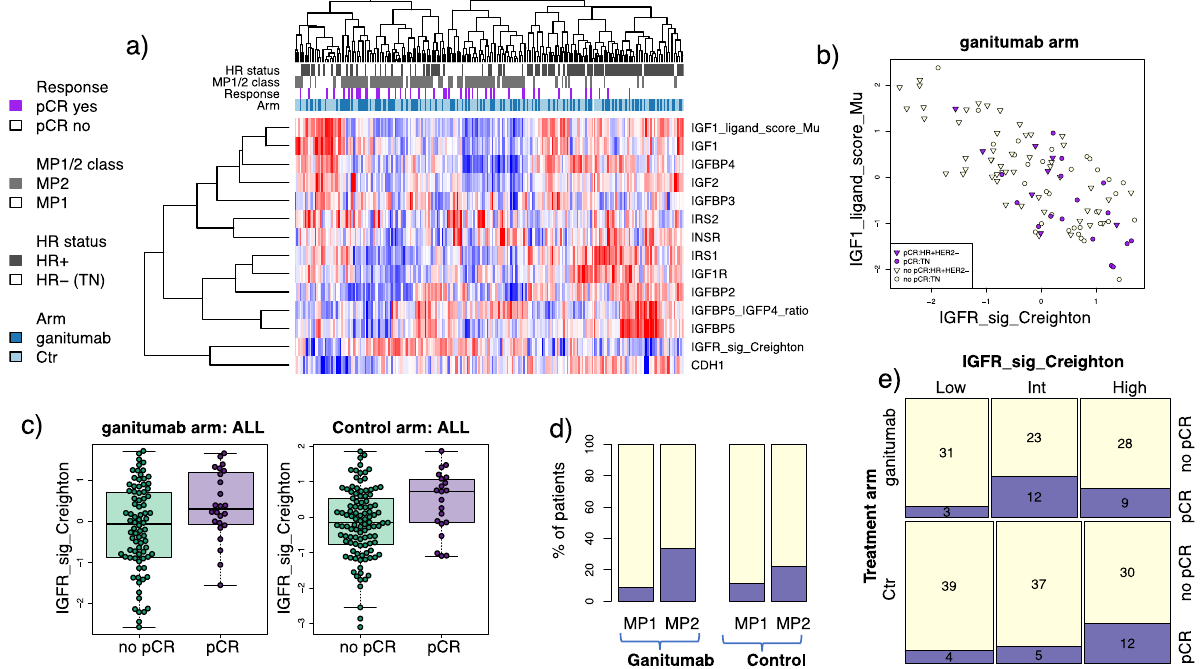
Fig. 3 Candidate expression biomarkers in the IGF-1R pathway. a Heatmap of biomarkers evaluated. Patients are along columns and biomarkers are along the rows. Red indicates higher expression and blue lower. Annotation tracks re fl ects response (purple: pCR), HR status (black: HR + ), MP 1/2 class (gray: MP2), and arm (dark blue: ganitumab). b Scatter plot showing IGF-1-ligand score vs IGFR Signature, ( c ) boxplots showing IGFR Signature levels in pCR vs. non-pCR patients in each arm (center line is group median; upper and lower limits of the box correspond to the 1st and 3rd quartile with whiskers extending to 1.5 times the interquartile range from top/bottom of the box); d – e pCR rate in ( d ) the MP1 vs. MP2 class and ( e ) IGFR-Signature groups by